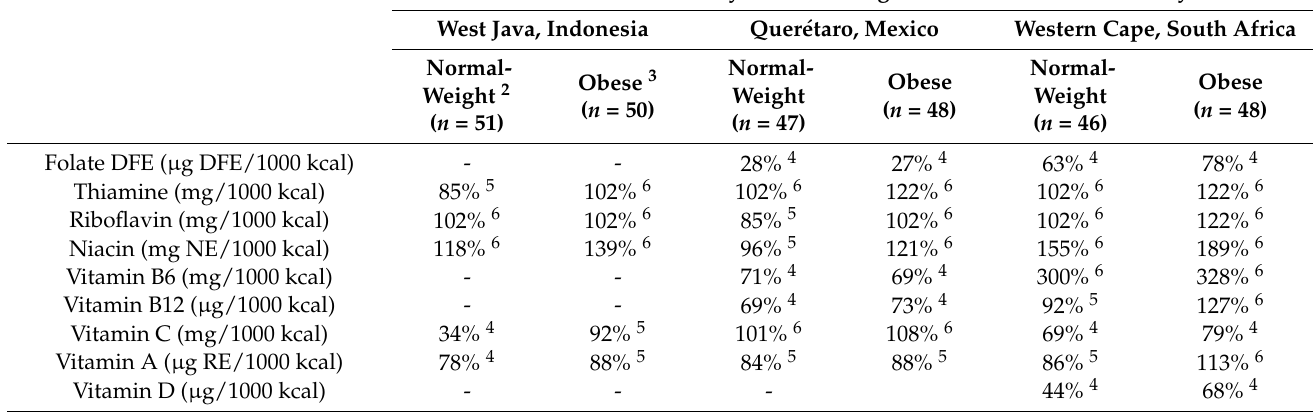
The observed micronutrient densities as a percentage of critical nutrient densities presented in Table 4 are presented in Table 6. The cells highlighted in orange indicate a percentage below 80%; these nutrients are classified as “problem nutrients” in the diets of the sampled women. In Indonesia, vitamins C and A were identified as problem nutrients among normal-weight women; calcium and iron were identified as problem nutrients for both normal-weight and obese women. In Mexico, calcium was identified as a problem nutrient among normal-weight women; folate, vitamins B6 and B12, and iron were identified as problem nutrients for both normal-weight and obese women. In South Africa, folate, vitamin D, calcium, and iron were identified as problem nutrients for both normal-weight and obese women. Table 6. Observed micronutrient density as a percentage of critical nutrient density by survey area for normal-weight vs. obese